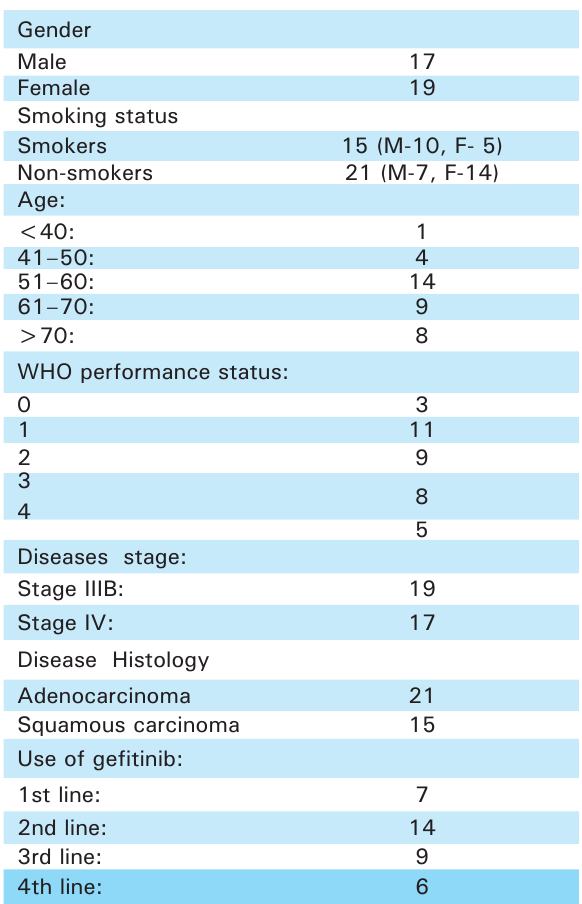
Table 1 . Patient characteristics